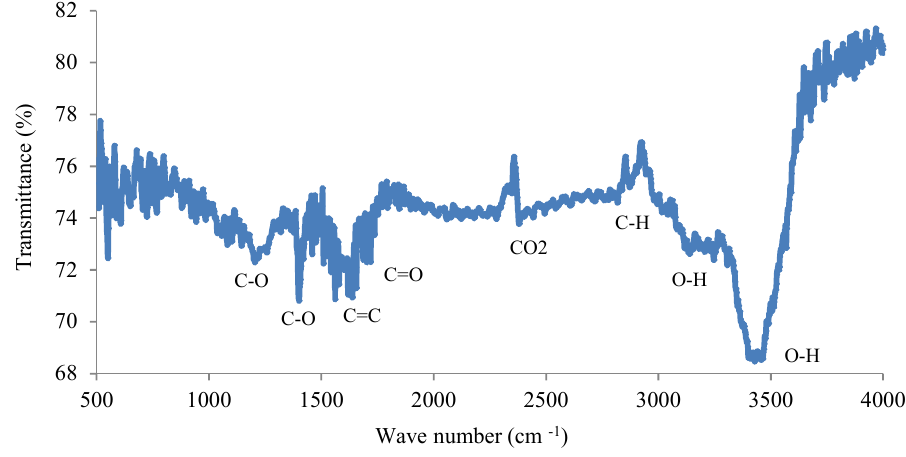
Fig. 1. FTIR spectra of MCPAC